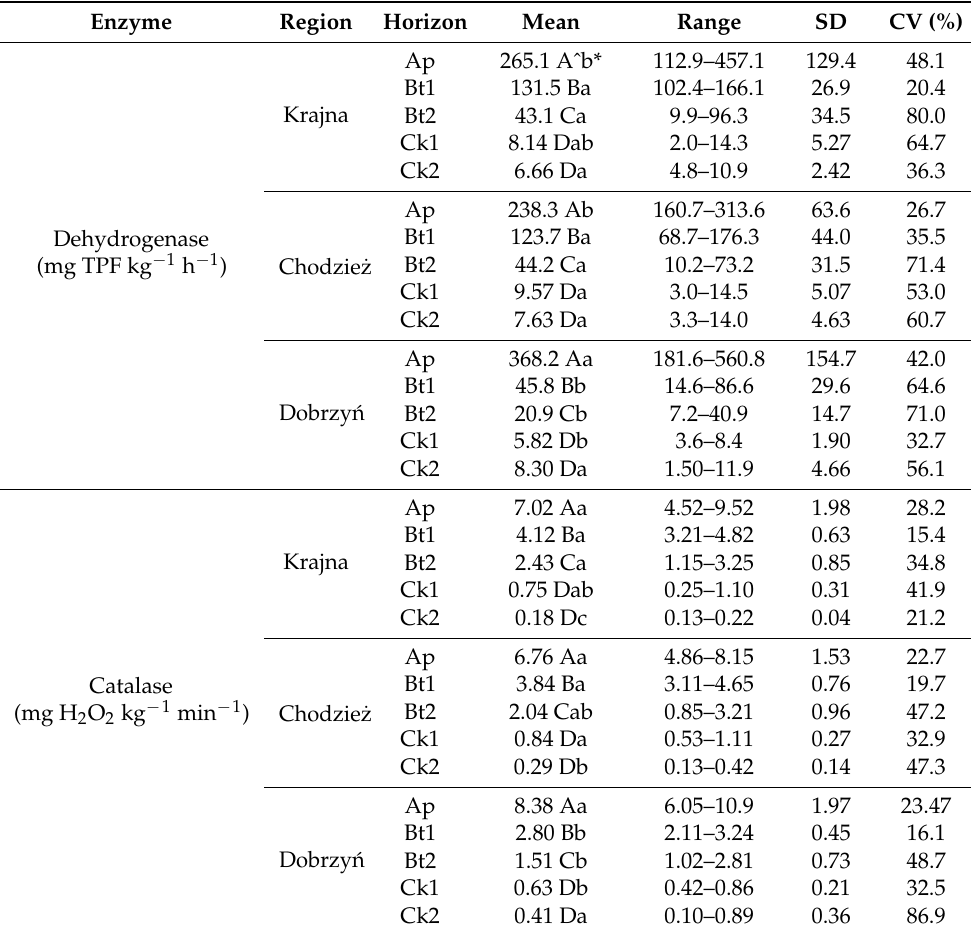
Table 2. Basic statistics of studied soil